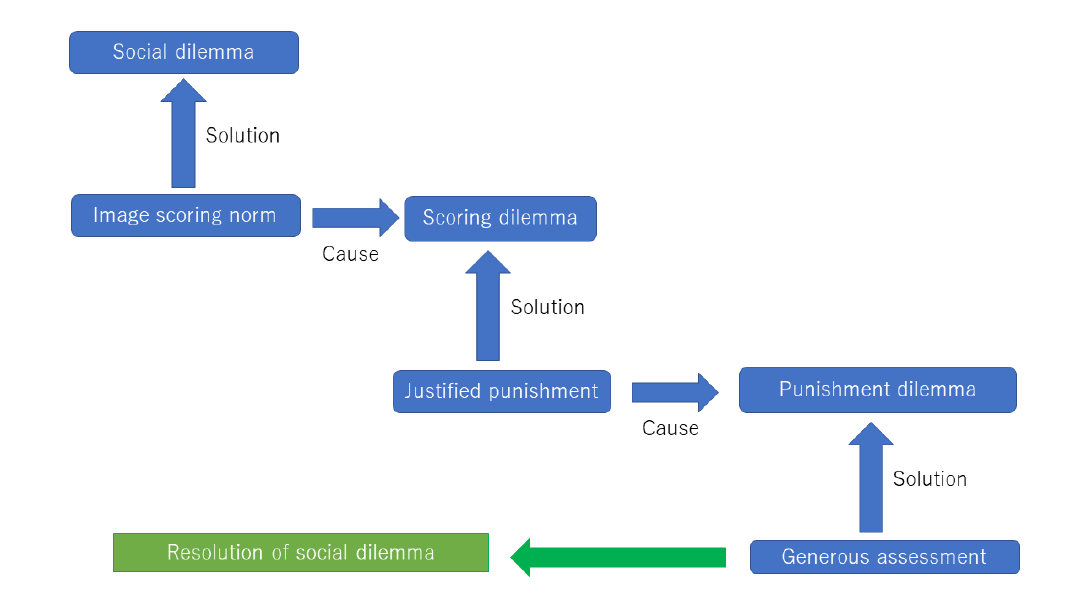
Figure 4. Resolving social dilemmas using indirect reciprocity. This figure is based on Figure 2 of Okada (2020)